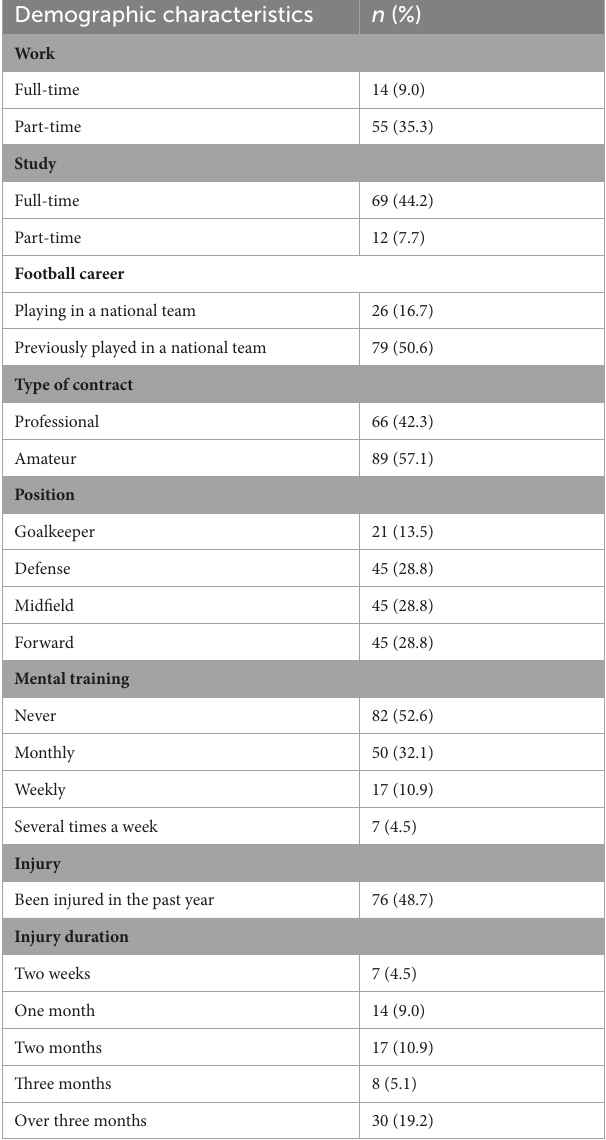
TABLE 1 Demographic characteristics of the participants ( N = 156). Demographic